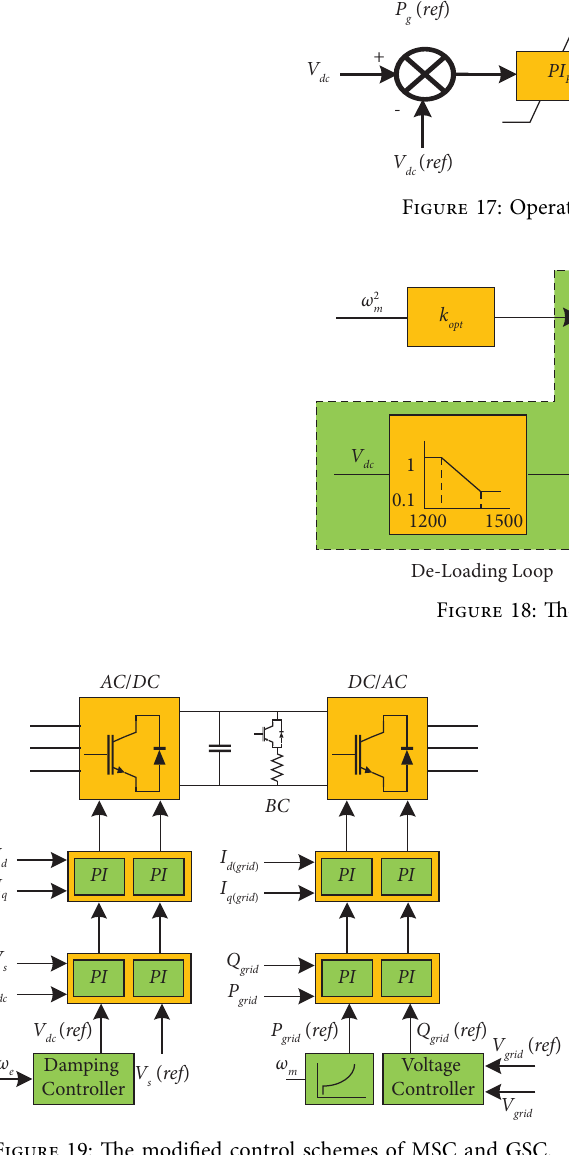
Figure 19: Te modifed control schemes of MSC and